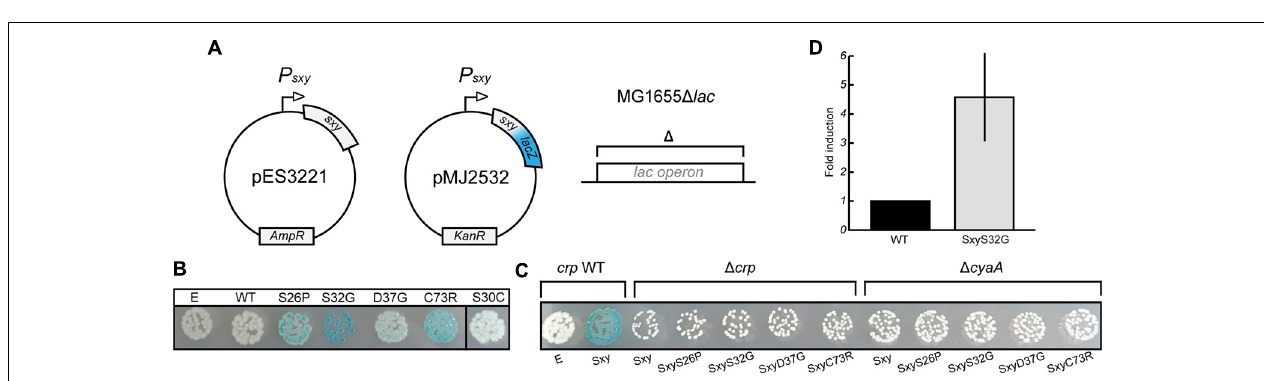
FIGURE 3 | Isolation of constitutive Sxy mutants. (A) Schematic overview of the experimental setup to find Sxy mutants that is more active than wild-type (WT). The sxy coding sequence was mutated by error-prone PCR in plasmid pES3221 and the mutant library was transferred into MG1655 (cid:49) lac cells carrying a plasmid borne P sxy - lacZ reporter (pMJ2532) (Jaskolska and Gerdes, 2015). (B) Phenotypes of four constitutive mutants, S26P, S32G, D37G, and C73R on LB X-gal plates. Cells carrying an empty vector (E, pES3221 without sxy ) and pES3221 with WT sxy are shown for reference. SxyS30C, isolated as a suppressor for CRPQ194R, is not constitutive. (C) Activation of “CRP-S” promoters by constitutive sxy mutants depends on CRP and cAMP, as no LacZ activity was observed in MG1655 (cid:49) lac (cid:49) crp /pMJ2532 and MG1655 (cid:49) lac (cid:49) cyaA /pMJ2532 cells. (D) Activity of the chromosomal sxy S32G allele relative to WT. Sxy activity was quantified in MG1655 (cid:49) lac and MG1655 (cid:49) lac sxy S32G cells using a plasmid borne P sxy -yfp reporter (pES91). The quantifications ± 1 SD are the results of three biological replicates as described in the section “Materials and